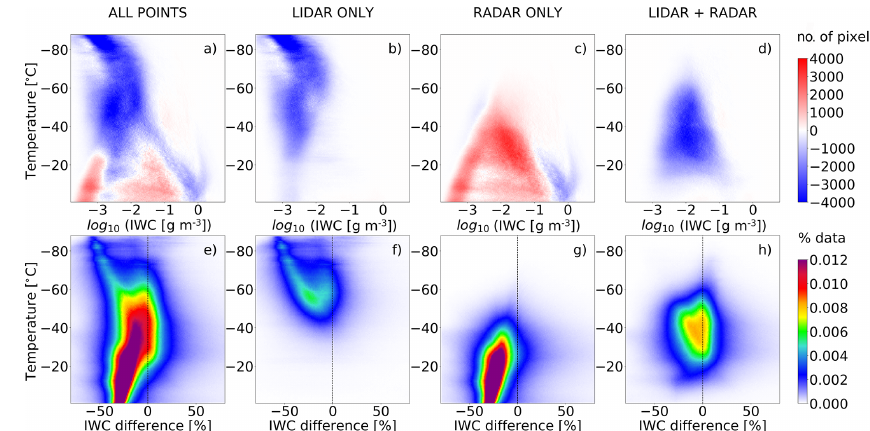
Figure 10. Comparison of the retrieved IWC between V 2 and V 3 : same panels as for Fig.